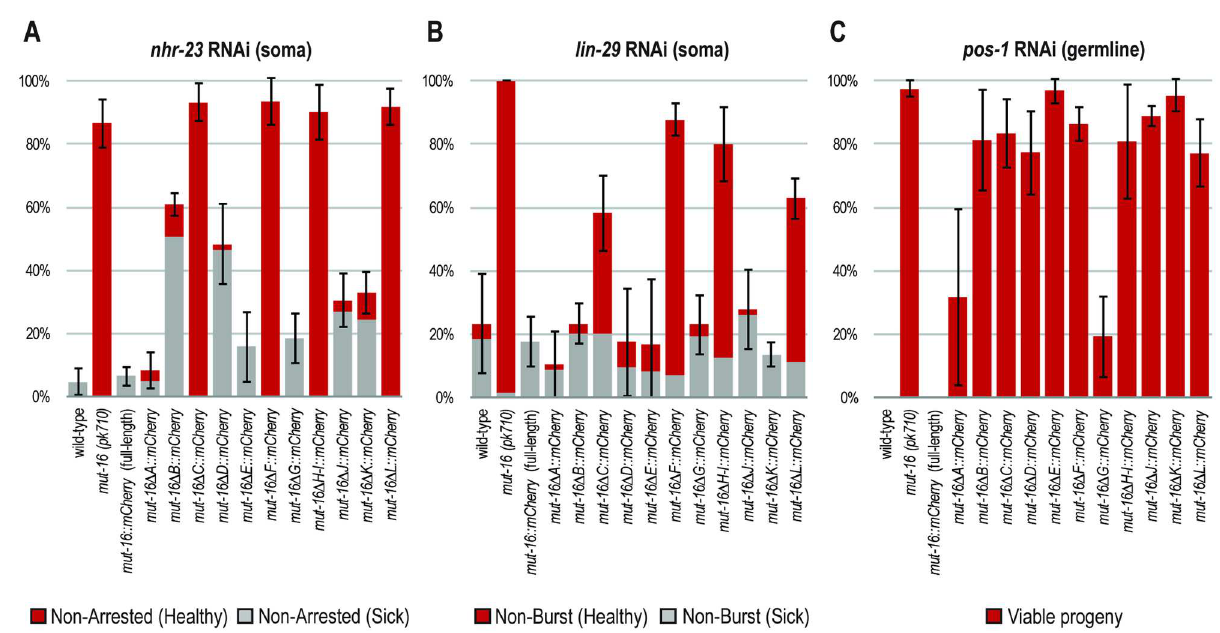
Fig 2. Susceptibility of mut-16 deletion worms to somatic and germline RNAi. (A-C) mut-16 deletion worms were assayed for their ability to respond to somatic ( nhr-23 or lin-29 ) or germline ( pos-1 ) RNAi. For nhr-23 RNAi (A) and lin-29 RNAi (B), P0 animals were scored as having intermediate RNAi defects (gray bars), or fully penetrant RNAi defects (red bars). For pos-1 RNAi (C), the F1 eggs and hatched larvae were counted to calculate % viable progeny from treated P0 animals. Weighted means and standard deviations were calculated from three independent RNAi trials of n = ~20 for nhr-23 and lin-29 , and n = ~90 F1 eggs from 4 P0 adults for pos-1 .